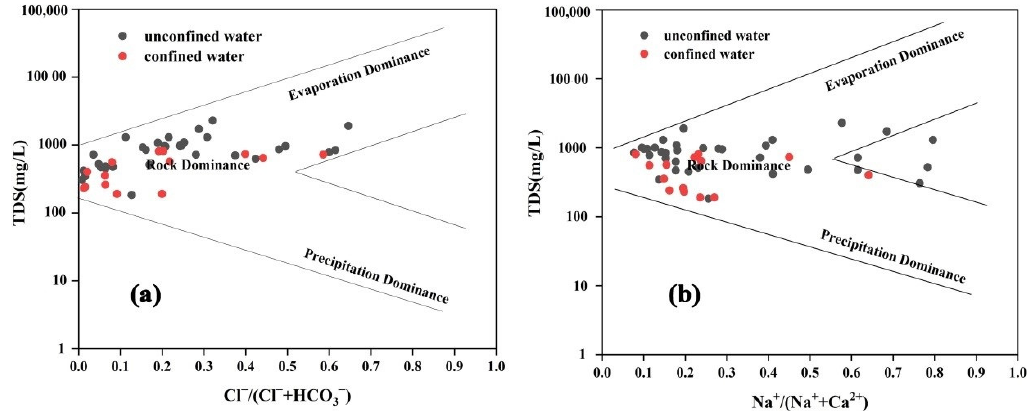
Figure 8. Piper diagram of 48 groundwater samples in the study area.